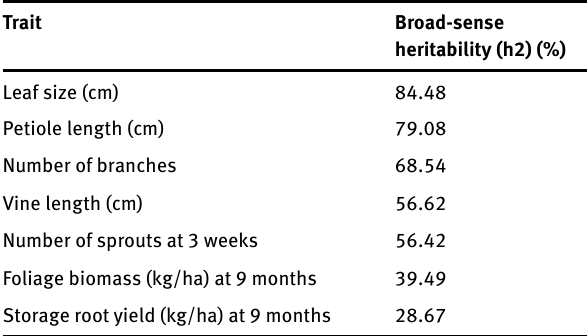
Table 5: Broad sense heritabilities for the measured traits across Umbeluzi, Nwalate and Gurue Research Stations in 2015